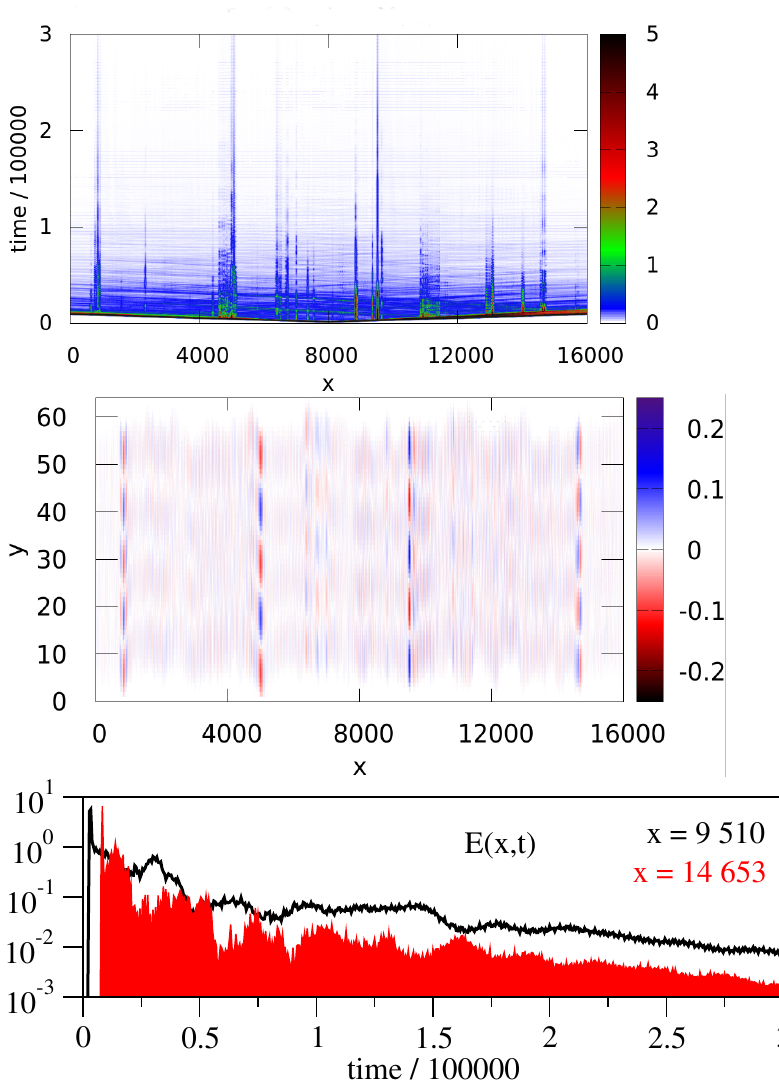
Figure 5. Space and time evolution of normalized energy in a weakly surface disordered sample, with ( d , l c , h , L ) = (64, 200, 6, 16,000). A set of resonances excited by an external source with period τ = 23 corresponds to localized phonons with eigenfrequencies ≈ 2 π / τ lying in the lower part of the acoustic frequency band. Note the length of the sample L = 16,000 and the time of simulations, 3 × 10 5 in comparison with the period T = 23 of excited acoustic waves. Perfectly absorbed boundary conditions [149] were implemented at the left and right boundaries of the wire in order to eliminate any reflection of the energy: Upper panel : the space–time dependence of the amplitude of the acoustic wave; Middle panel : the spatial distribution of energy E ( x , y ) at a time t = 194,400; Lower panel : time evolution of the energy at x = 9510 and x = 14,653. Localized states are first excited by phonons from the source (the narrow maxima at the beginning of the time evolution) which then exchanges their energy with other localized states in its neighborhood. The energy of a localized state close to the boundary exponentially decreases due to loss through the right boundary of the sample